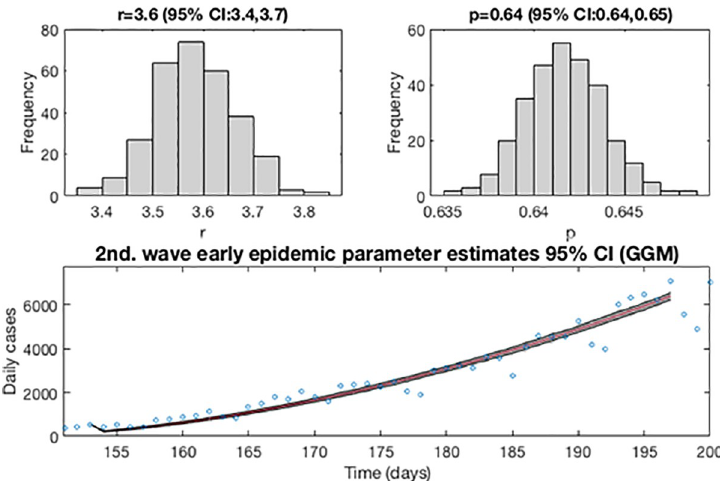
Fig 10. Resulting curves after re-fitting of parameters of the early epidemic phase. Blue circles are the cases reported daily; red line corresponds to the best fit of the GLGM to the data. Grey lines correspond to the m bootstrapping realizations of the epidemic curves. Black lines correspond to the 95% CI bounds. The empirical distributions for parameter estimations are displayed in the top panel.